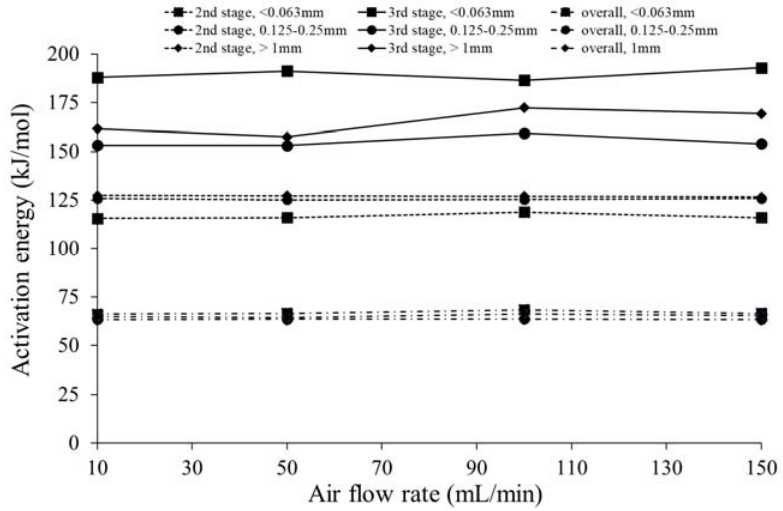
Figure 11. Estimated activation energy as a function of the air flow rate for the three di ff erent particle sizes.